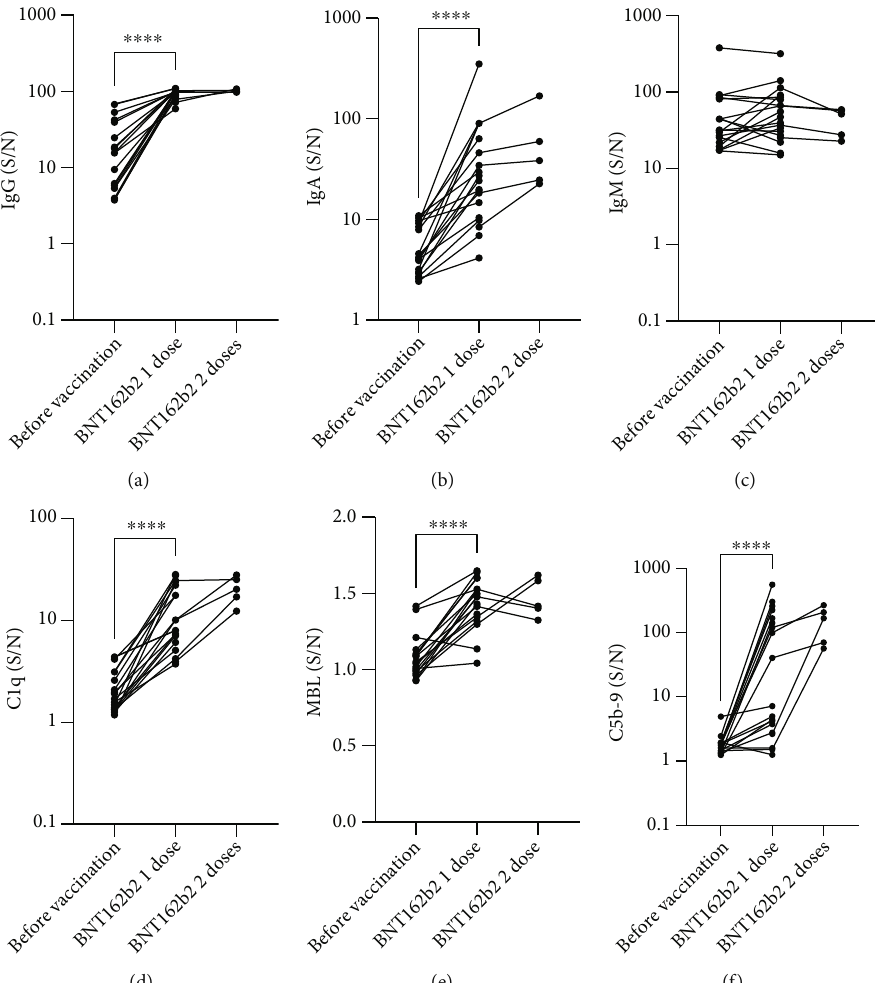
Figure 4: Complement activation before and after BNT162b2 vaccination. 19 participants provided samples before and after the fi rst dose of BNT162b2, and 5 participants provided samples before and after the second dose of BNT162b2. Serum samples were incubated with RBD- coated plates (a) bound IgG, (b) IgA, (c) IgM, (d) C1q, (e) MBL, and (f) formed C5b-9 were subsequently measured as described in the methods section. (S/N) represents the chemiluminescence signal generated from wells incubated with 1% serum divided by the signal in control wells incubated with PBST. Each circle in the scatter plots represents one sample, and the circles connected by lines represent before and after samples from the same participant. Only signi fi cant pairwise comparisons are displayed, ∗∗∗∗ P ≤ 0 : 0001